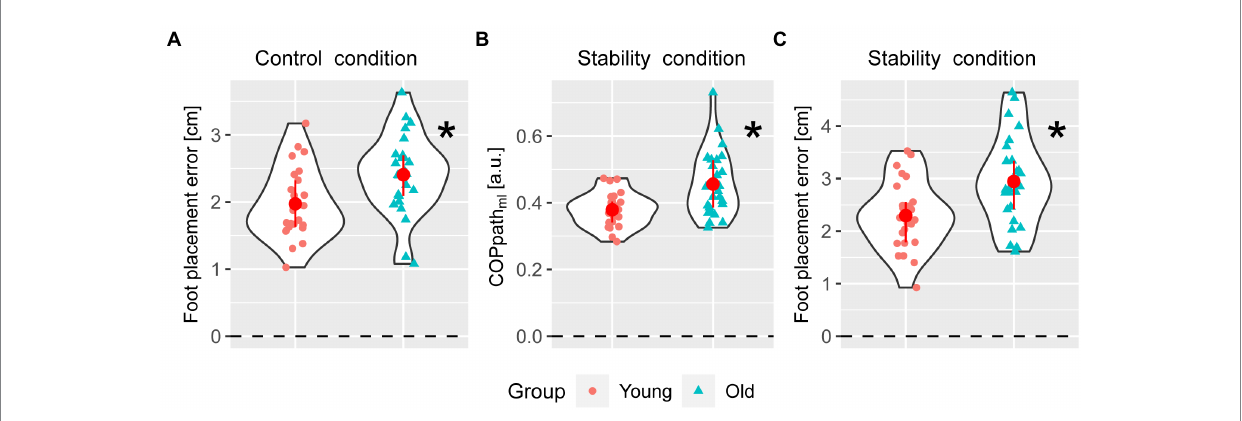
FIGURE 3 Significant differences in stepping outcomes between young and older adults. Between group differences in foot placement error in the control condition [Panel (A) ], and mediolateral center of pressure path length and foot placement error in the stability condition [Panel (B,C) ] with individual data points for young (circle) and older adults (triangles). The group median and interquartile range are represented by the red circle and whiskers.